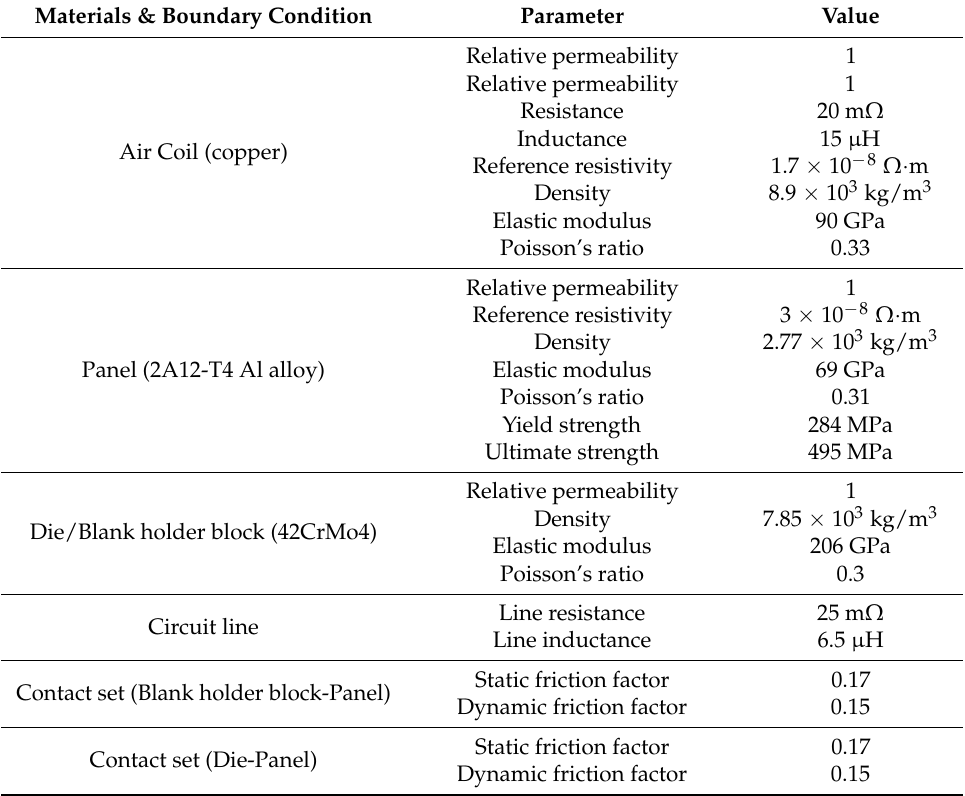
Table 3. System parameters and forming conditions during electromagnetic incremental forming for stiffened panels